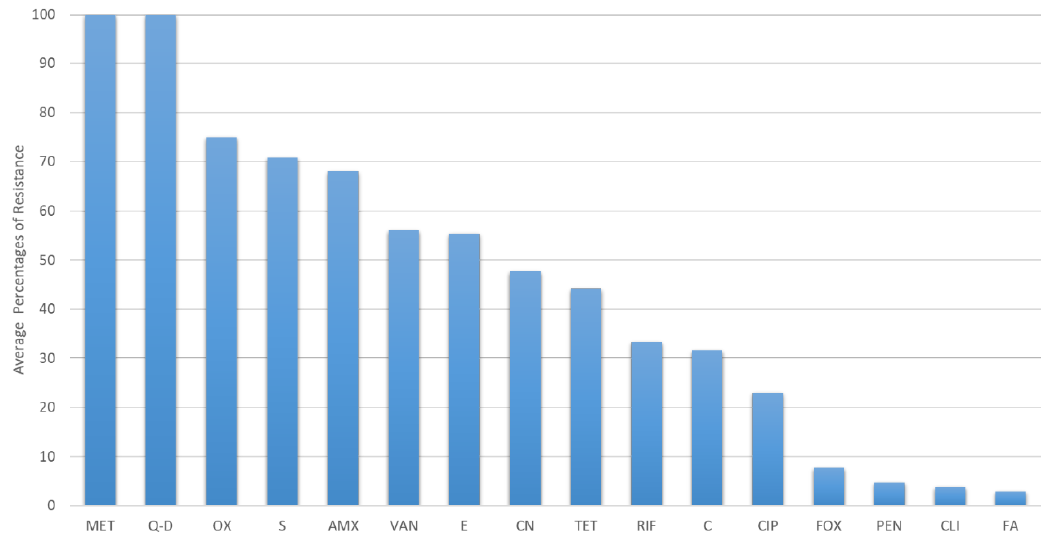
Figure 4. Major antibiotic resistance of gram-positive bacteria in bats. Methicillin = MET, Quinupristin-dalfopristin = Q-D, Oxacillin = OX, Amoxicillin = AMX, Streptomycin = S, Vancomycin = V, Erythromycin = E, Gentamicin = CN, Tetracycline = TET, Rifampicin = RIF, Chloramphenicol = C, Ciprofloxacin = CIP, Cefoxitin = FOX, Penicillin = PEN, Clindamycin = CLI, Fusidic acid = FA.